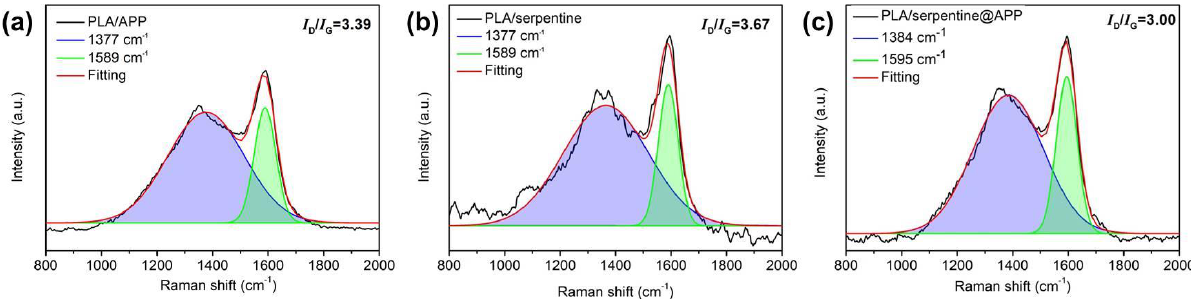
Figure 9. Raman spectra of the char residues of ( a ) PLA/APP, ( b ) PLA/serpentine, and ( c ) PLA/serpentine@APP.